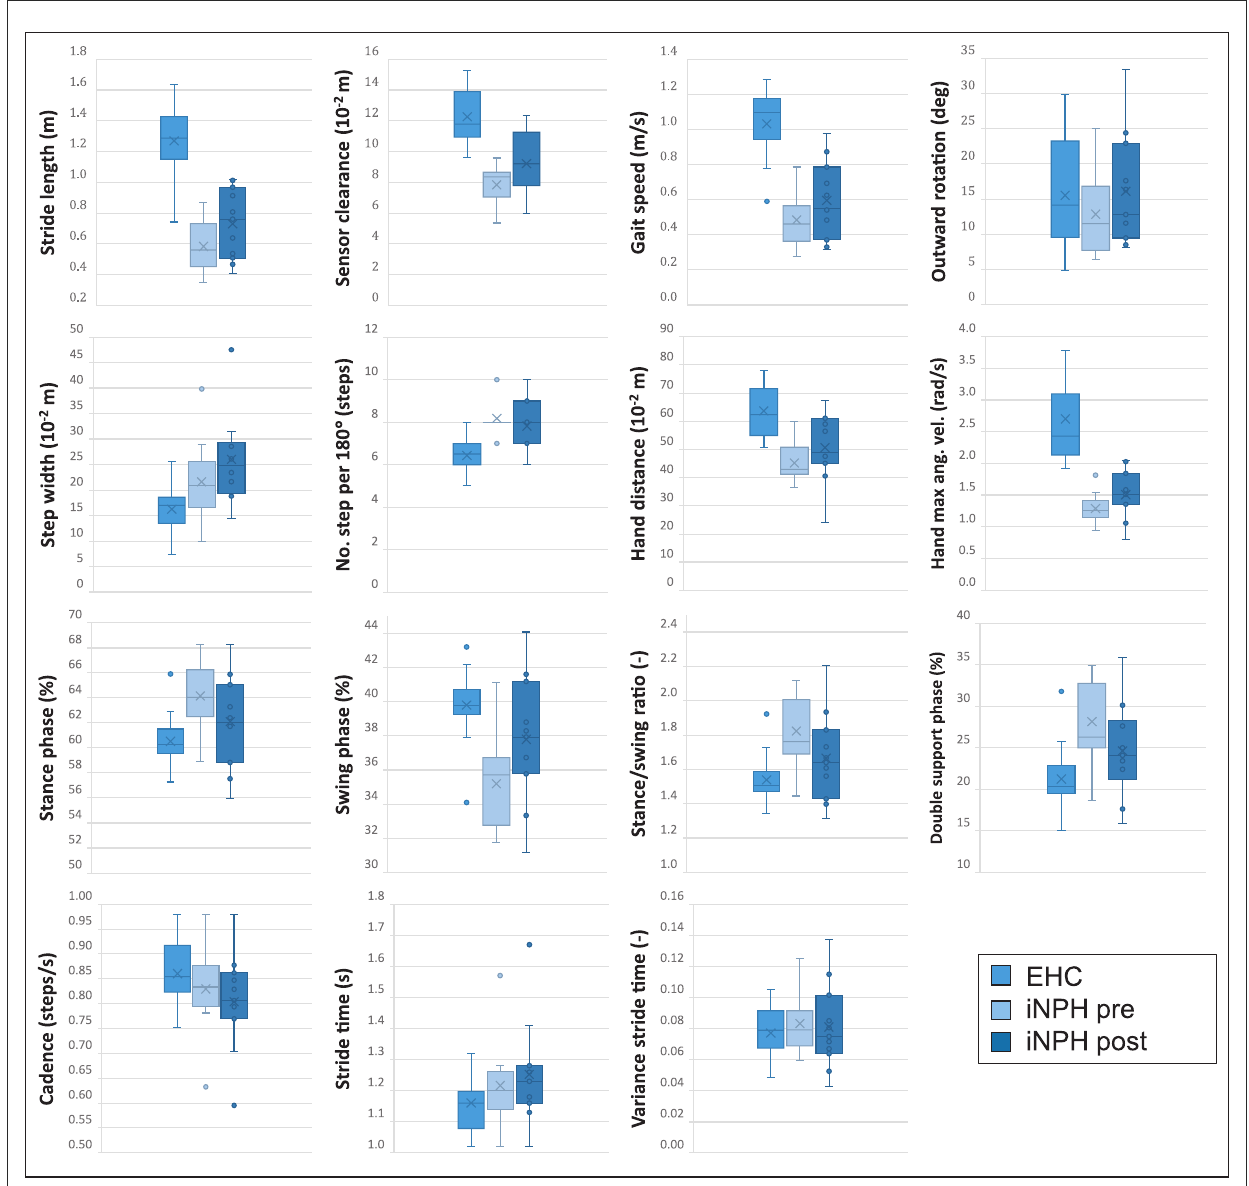
FIGURE2 All illustrated boxplots indicate the comparison in a real-world environment between 20 elderly healthy controls (EHC) and 11 patients with normal pressure hydrocephalus (iNPH) preoperatively and postoperatively after ventriculo-peritoneal (VP)-shunt implantation. The absolute difference between the parameter’s median values of every subject is indicated in each boxplot. Within each boxplot, the group’s mean values are indicated as a cross, and outliers are indicated as dots. The upper and lower edges of the box define the interquartile range, and the whiskers indicate the extreme data